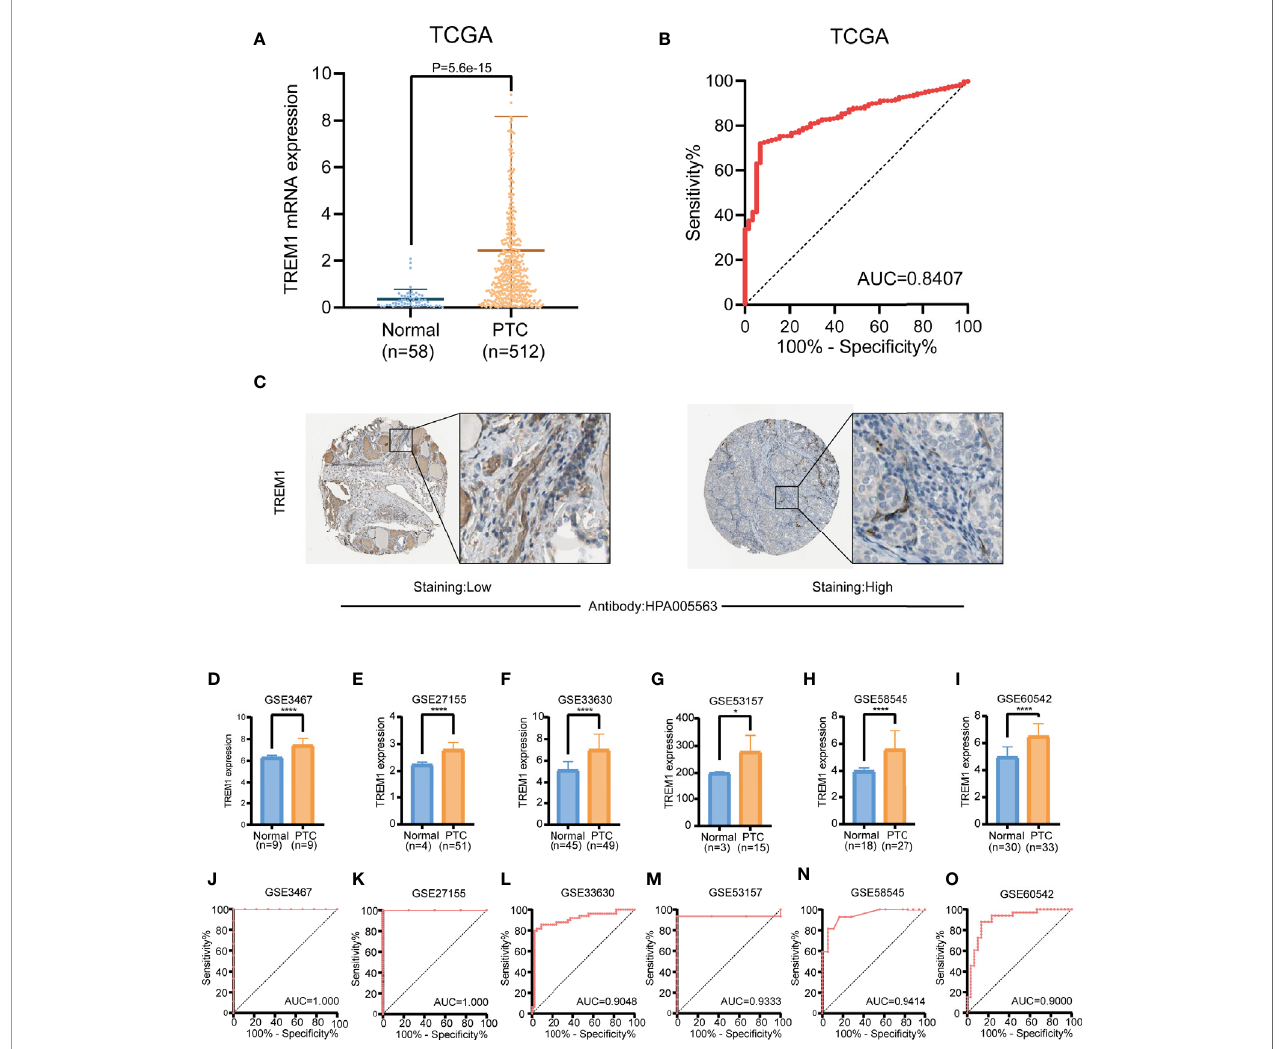
FIGURE 1 | Diagnostic value of TREM-1 in PTC. (A) Comparison of TREM-1 mRNA expression between PTC and normal tissues in TCGA. (B) Diagnostic ef fi cacy of TREM-1 as shown by the ROC curve. (C) Comparison of immunohistochemical images indicating TREM-1 expression in PTC and normal thyroid tissues. (D – I) TREM-1 mRNA expression in the six GEO veri fi cation cohorts (GSE3467, GSE27155, GSE33630, GSE58545, GSE53157 and GSE60542). (J – O) ROC curve showing the diagnostic performance of TREM-1 expression in the veri fi cation cohorts. *P < 0.05, ****P < 0.0001